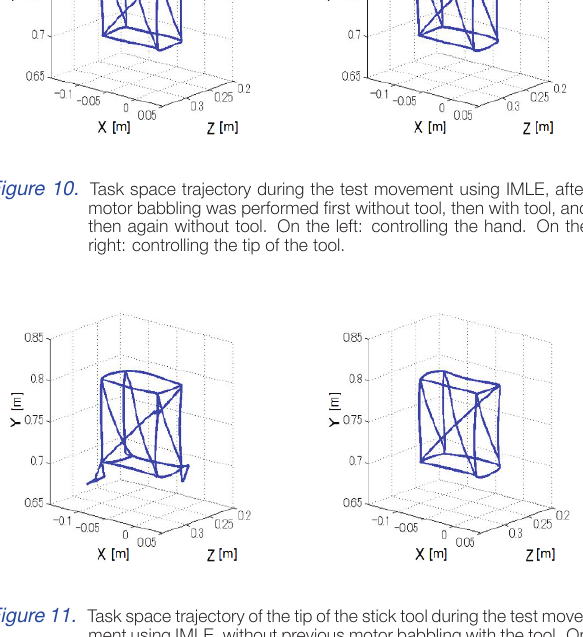
Figure 11. Task space trajectory of the tip of the stick tool during the test move- ment using IMLE, without previous motor babbling with the tool. On the left: first iteration of the movement. On the right: after 3 itera- tions of the movement.